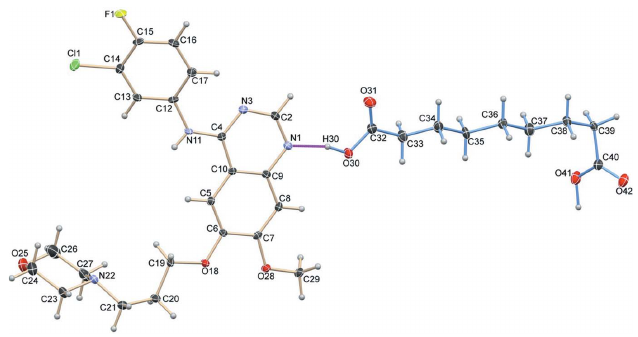
Figure 1 The asymmetric unit of the title compound, showing the atom labelling, 50% probability displacement ellipsoids for non-H atoms and hydrogen bonding with a dotted magenta line. H atoms are shown as small spheres of arbitrary radii.